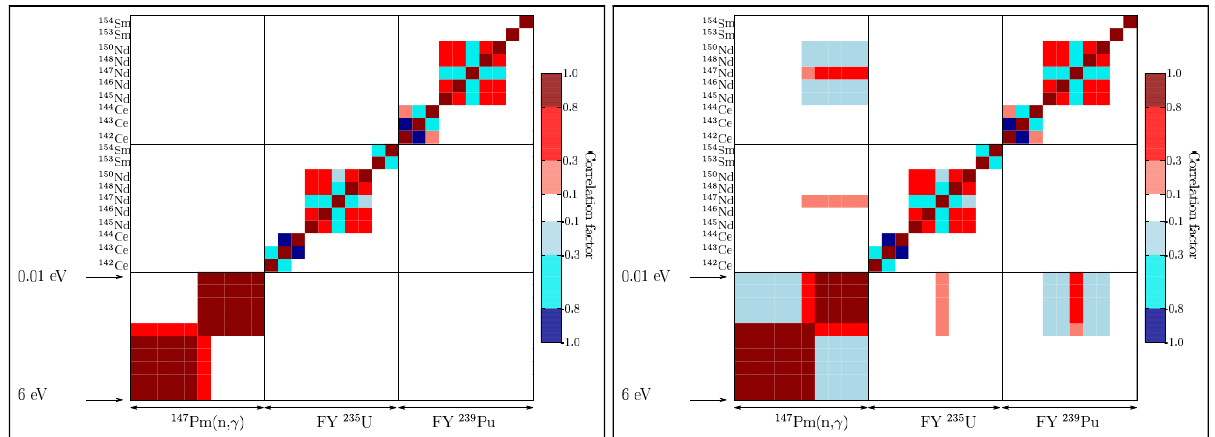
Fig. 3. Case of correlations between fission yields from 235 U, 239 Pu and 241 Pu. Left: prior correlation matrix without PIE data; right: posterior correlation matrix using the PIE measurement from 133 Cs.